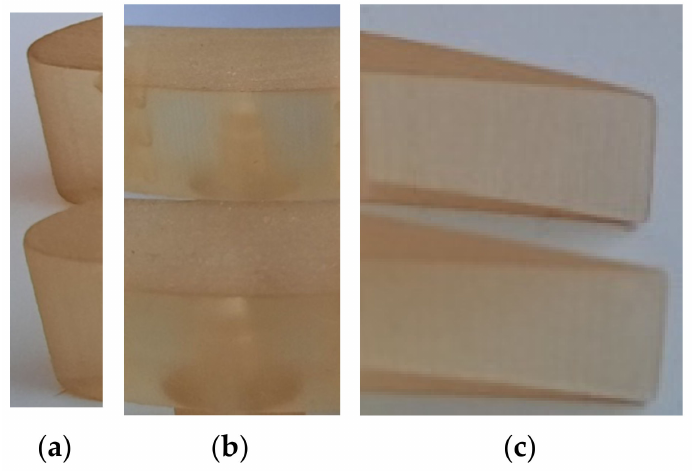
Figure 15. Comparative study of the airfoil surface in different interest locations for matte XY (upper) and matte YX (lower): ( a ) leading edge; ( b ) central zone; ( c ) trailing